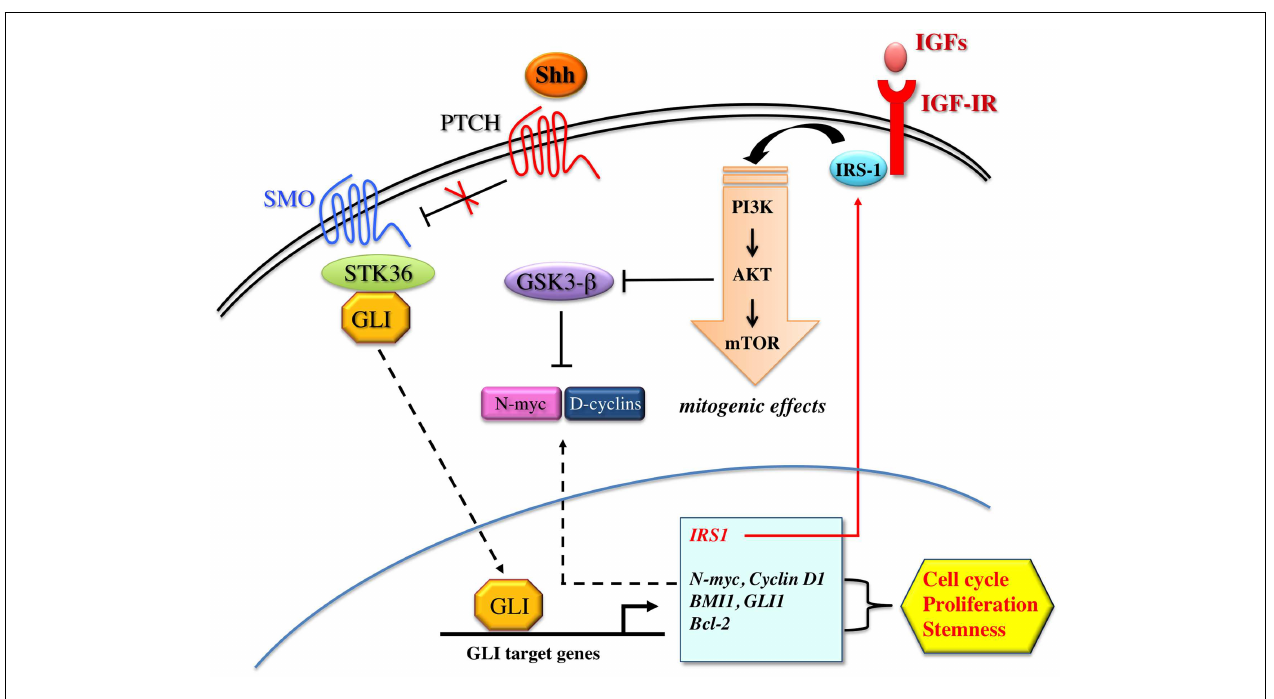
N-myc, D-cyclins, BMI1, GLI1, Bcl-2, and IRS-1, all of which have been implicated in cell cycle progression, proliferation, and stemness. IRS-1, in turn, mediates IGF-IR/PI3K signaling activation, which inhibits GSK3 β -mediated phosphorylation and consequent increased degradation of N-myc and D-cyclins. However, Shh may also activate IGF-IR/PI3K pathway via unknown intermediary